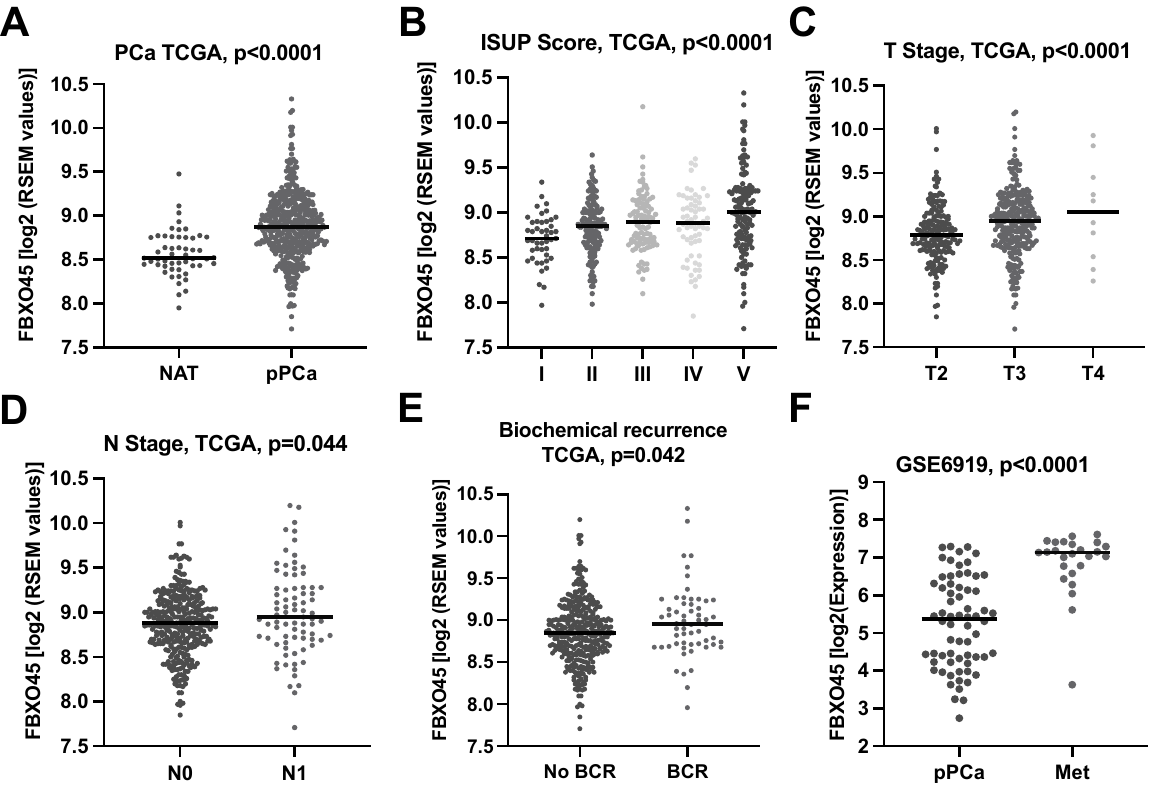
Figure 1. FBXO45 expression is enhanced in aggressive primary prostate cancers (pPCA) and distant metastasis (Met). ( A – E ) are based on the PCA TCGA dataset: ( A ) Distribution of FBXO45 RNA expression in normal adjacent prostatic tissue (NAT) in comparison to primary prostate cancer (pPCA). ( B ) The scatter plots depict FBXO45 RNA expression across ISUP subgroups ( B ), by T Stage ( C ), by N Stage ( D ) and by biochemical recurrence status (BCR) in ( E ). ( F ) Illustration of FBXO45 RNA expression in pPCA compared to distant metastasis (Met) in the PCA progression cohort GSE6919.